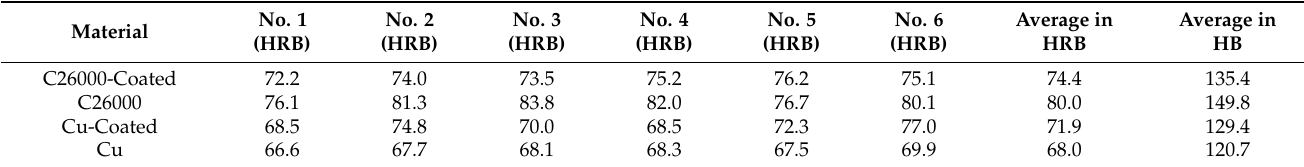
Table 1. Hardness test results in both HRB and HB